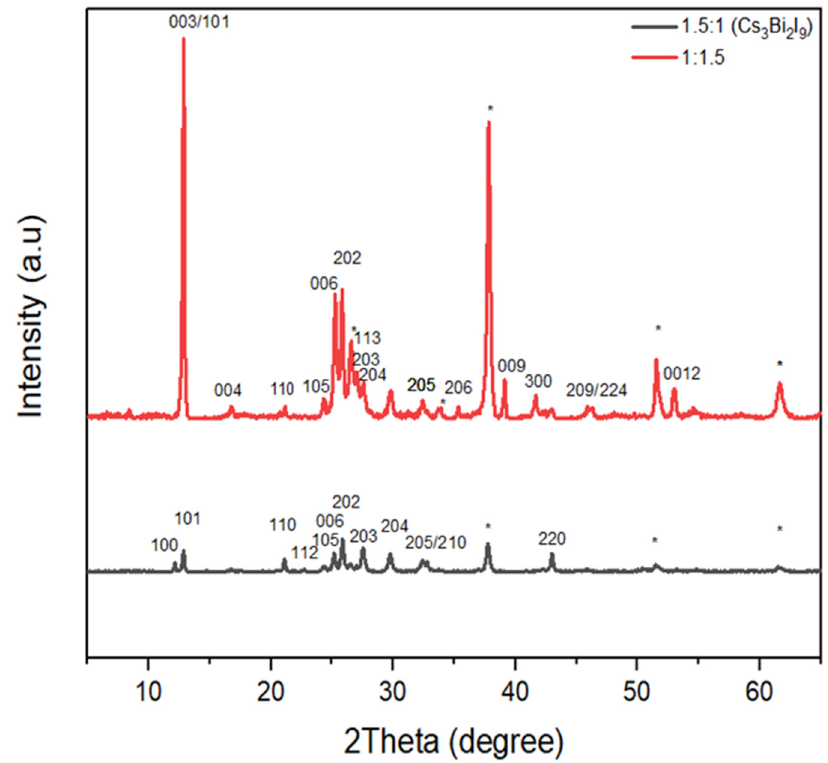
Figure 7. XRD comparisons for caesium bismuth iodide perovskite formed at (CsI/BiI 3 ) ratios 1.5:1 and 1:1:5. * Caesium bismuth iodide at ratio 1:1.5, on the other hand, was found to have additional characteristics peaks at 009,012,209 and 300, indicating the growth of another phase.